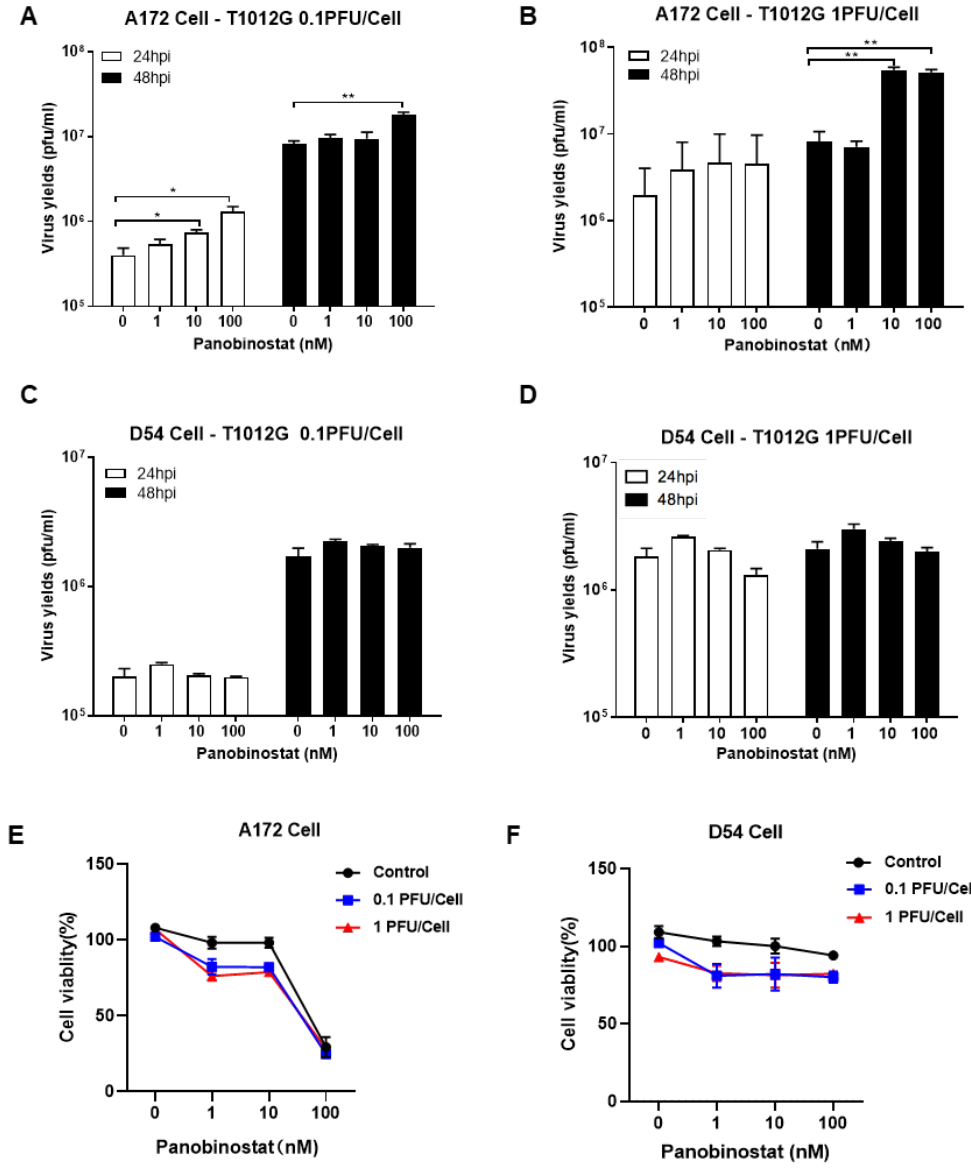
Figure 1. The HDACi panobinostat promoted oHSV replication and tumor-cell killing in human glioma A172 cells. Human glioma cells A172 ( A , B ) and D54 ( C , D ) were pretreated with panobinostat at concentrations of 1, 10, and 100 nM for 14 h and then infected with T1012G (0.1 or 1 PFU/Cell) for another 48 h, respectively. The infected cell pellets were harvested at 48 hpi. The titration was measured by conventional plaque assay on Vero cells after three freeze–thaw cycles. The tumor-cell- killing activity was assessed using a CCK8 assay. A172 ( E ) and D54 ( F ) cells were mock- or